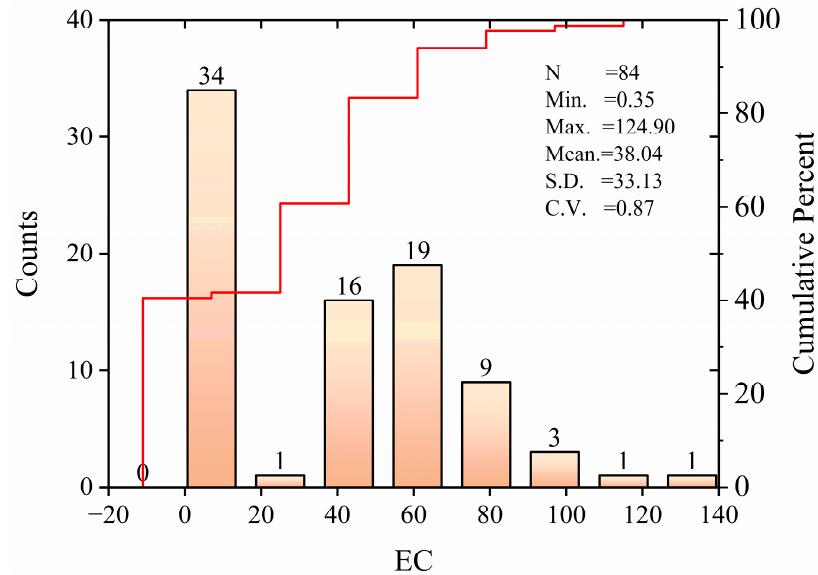
Figure 2. A statistical plot of the actual measured soil salinity data. Table 5. Descriptive statistics of the soil EC data.